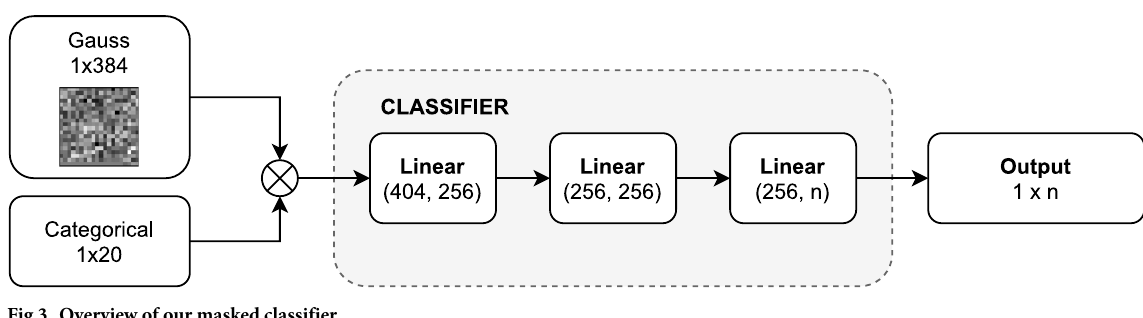
Fig 2. Overview of our encoder-decoder architecture.